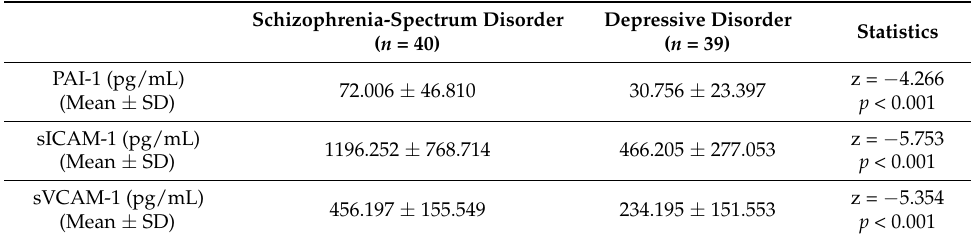
Table 4. Cell adhesion molecule levels in the cerebrospinal